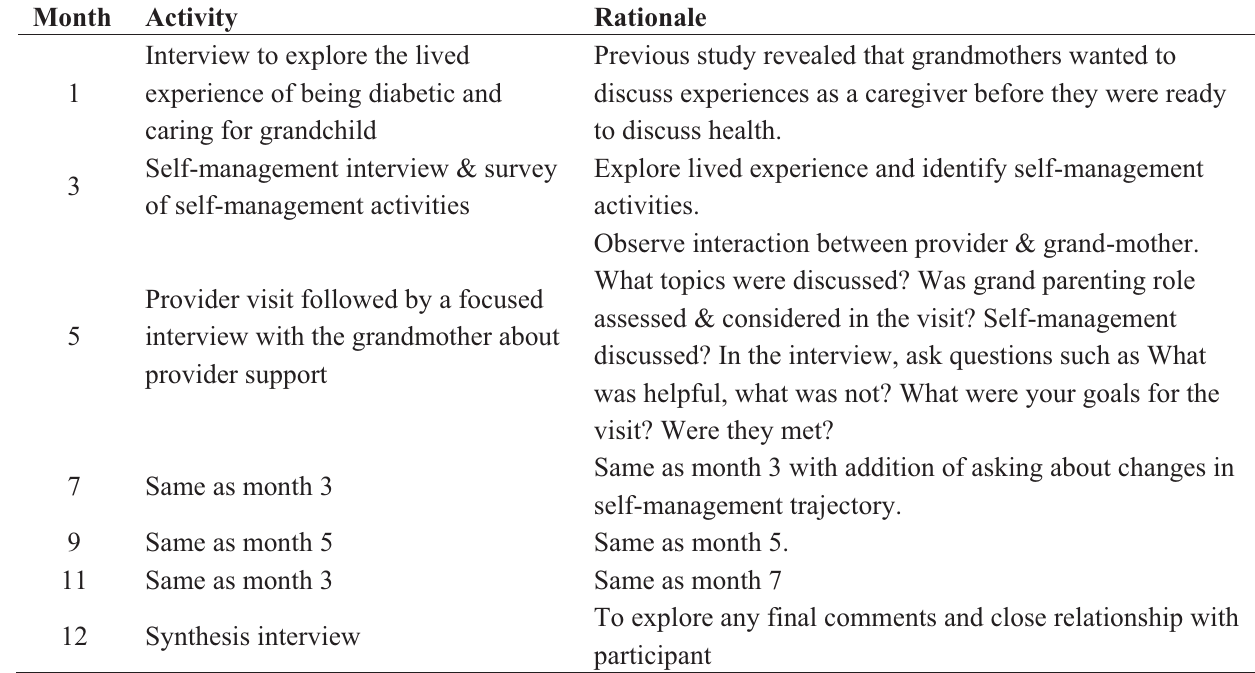
Table 2. Data collection activities and rationale.